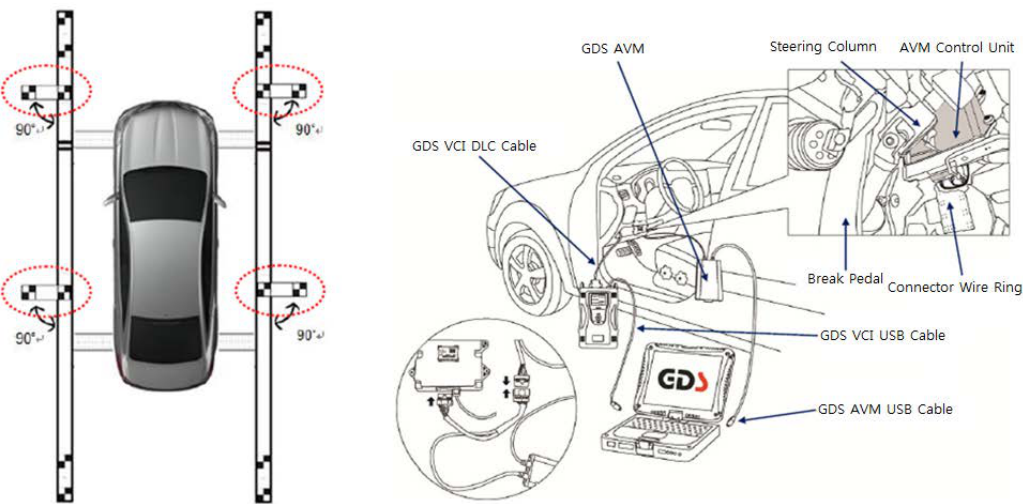
Figure 2. Example of the calibration pattern ( left ) and external equipment ( right ) used for recalibrating the AVM system [3].